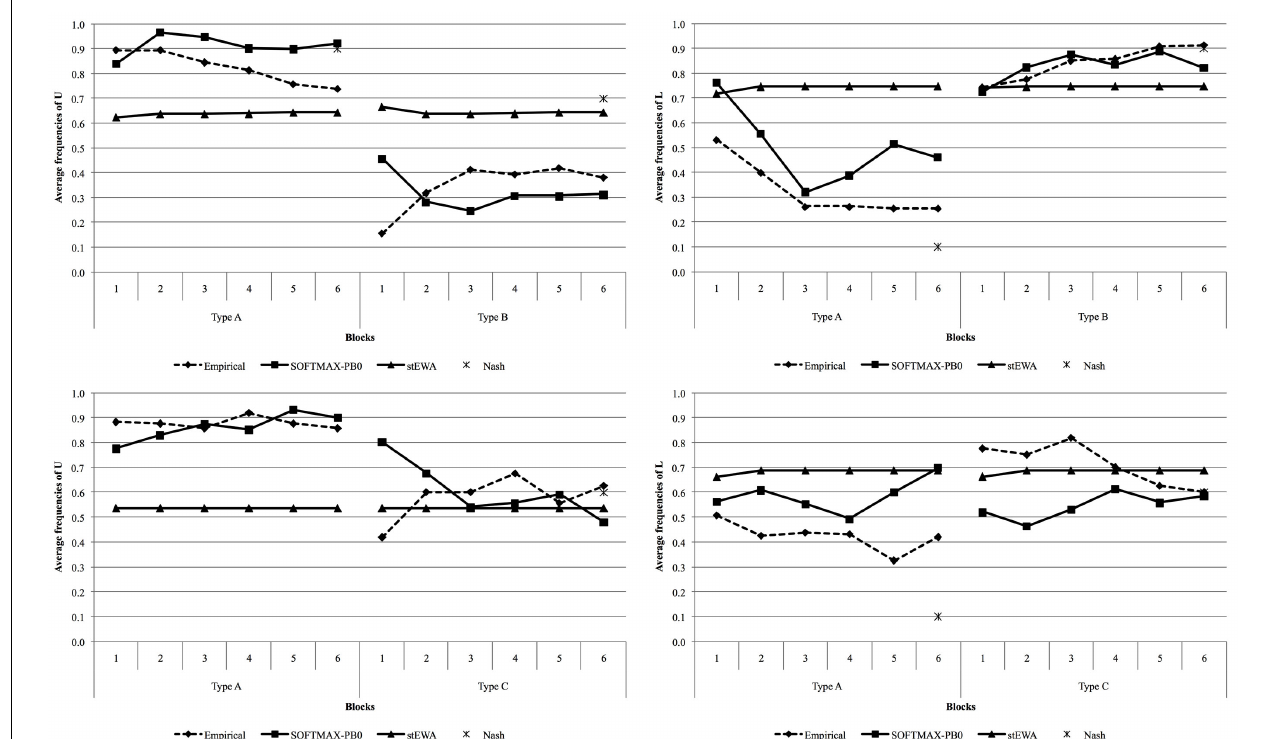
FIGURE 4 | Predicted and observed choice frequencies in Experiment 1 (top panels) and 2 (lower panels).